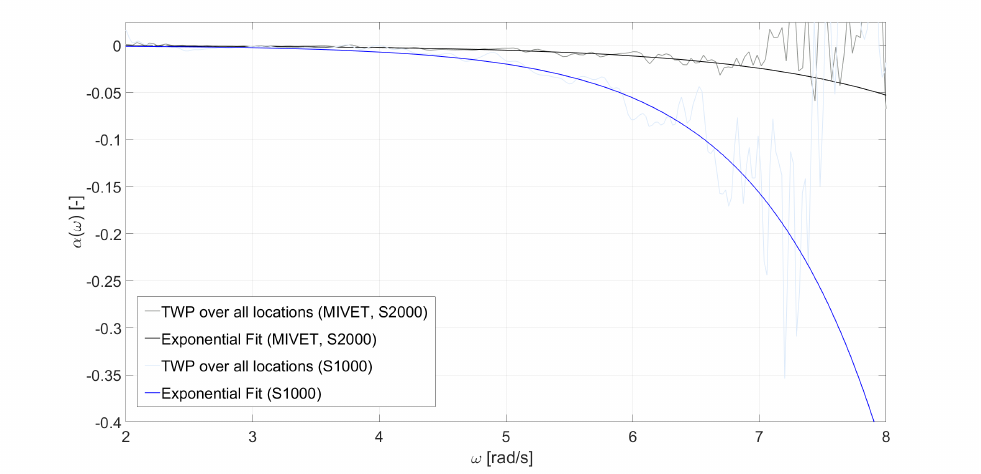
Figure 10. Damping coefficient for MIVET (S2000) and conventional model ice (S1000) together with an exponential